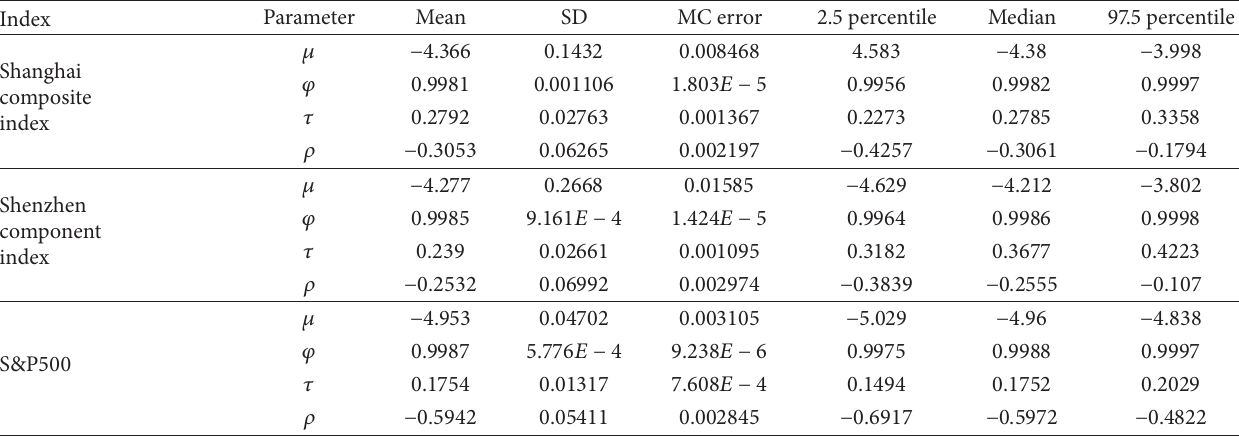
Table 6: Estimation results of the leverage SV model for three indices.